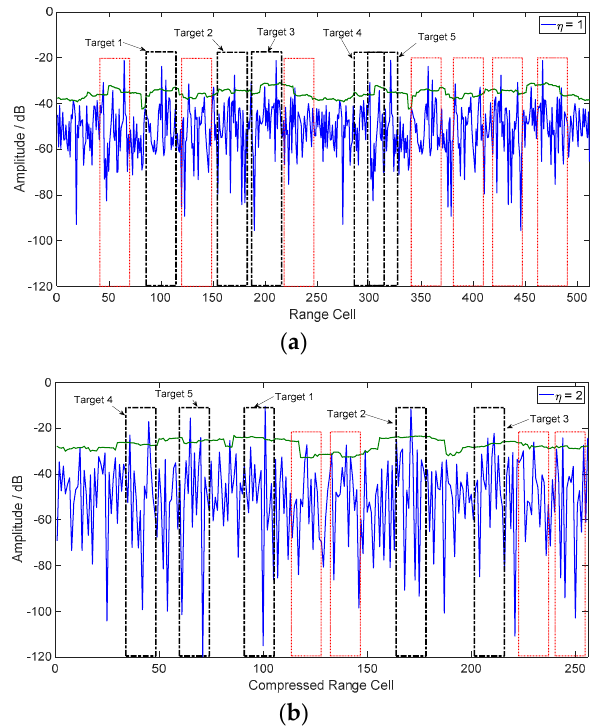
Figure 7. Subspace extraction results by denoising constant false-alarm ratio (CFAR) detection. ( a ) η = 1; ( b ) η = 2. The green line represents the CFAR threshold. The black dashed box represents the extracted index set where the real target is located. The red dashed box represents the extracted false-alert index set.